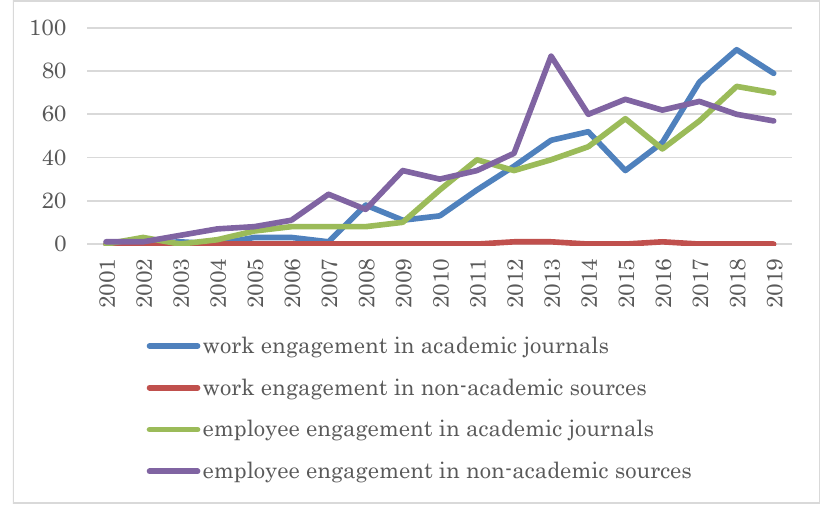
Figure 1. Number of articles with WE or EE in the title (Business Source